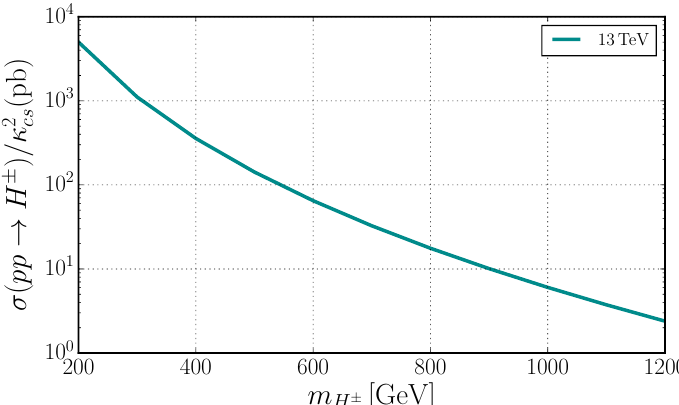
at the LHC ( p s = 13 TeV). H (cid:6)